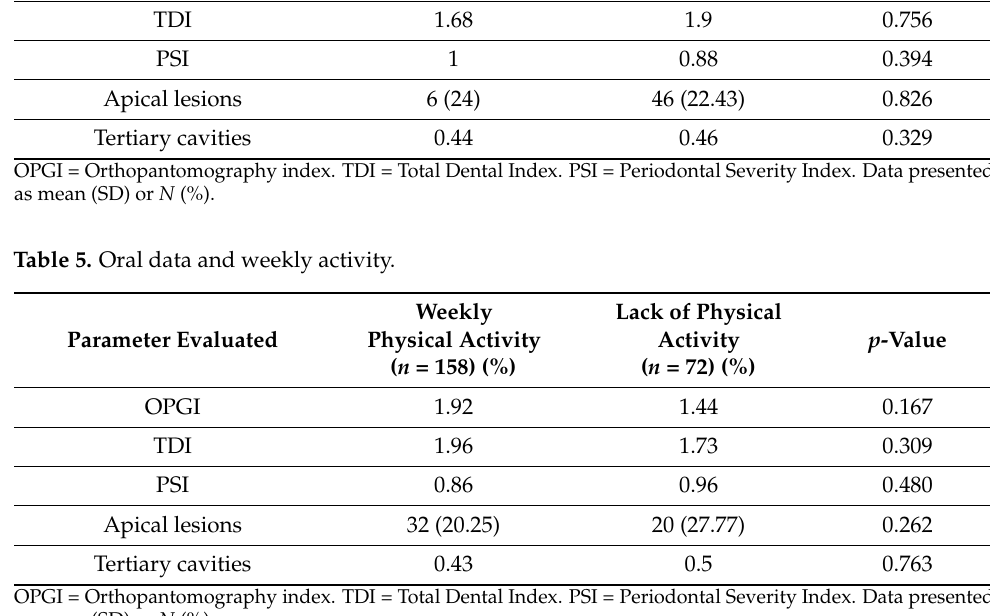
Parameter Evaluated